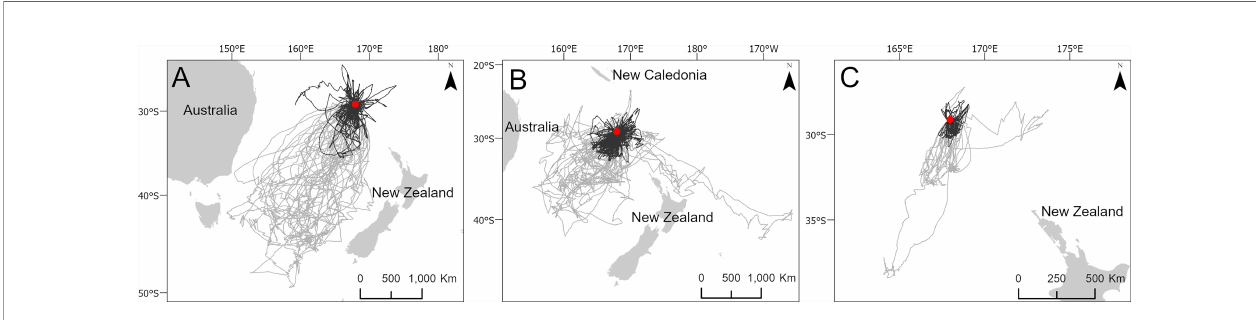
FIGURE 3 | Maps demonstrating the short (black) and long (grey) foraging trips of black-winged petrel (A) , white-necked petrel (B) and Kermadec petrel (C) bimodal foraging strategies. The colony location is indicated by a red circle. The number of trips in each category are detailed in Table 2 .